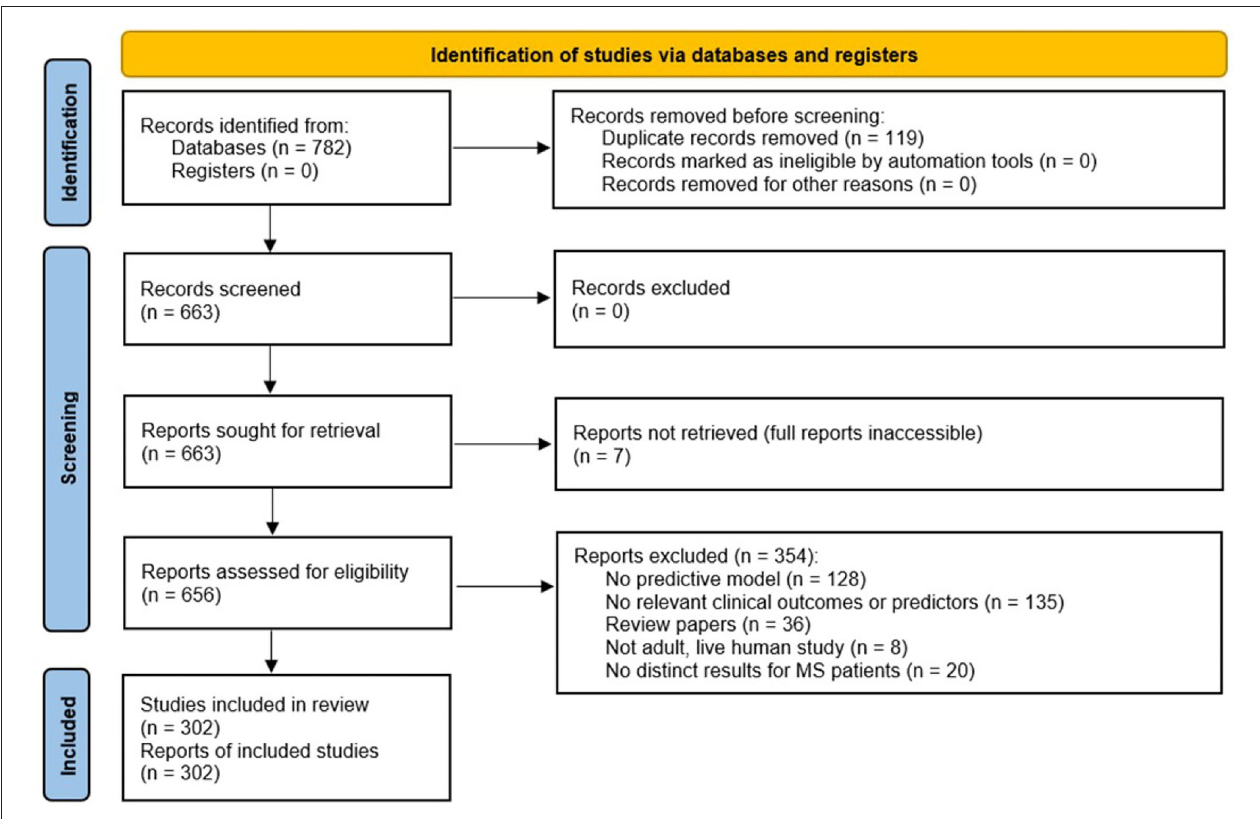
FIGURE 1 | Preferred Reporting Items for Systematic Reviews and Meta-Analyses (PRISMA) chart summarizing the disposition of records identified from PubMed searches. The searches identified 782 records, of which 663 were unique. After several exclusion criteria defined in the figure, 302 unique records were included in the